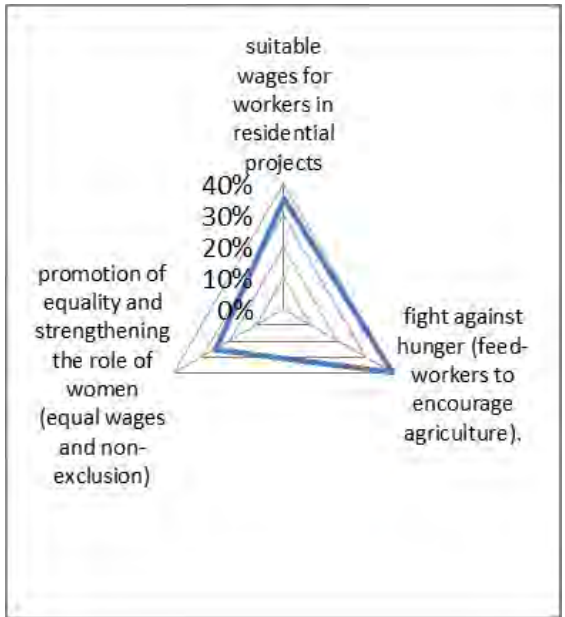
Figure 4. Fighting poverty and hunger